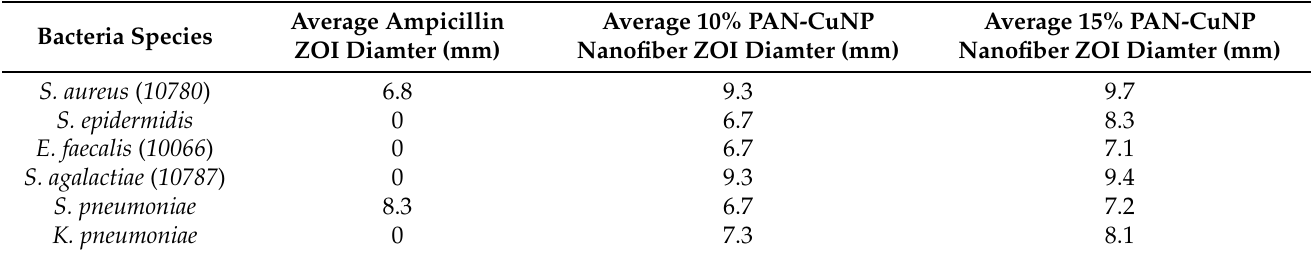
Table 4. Antibacterial Efficiency of PAN-CuNP nanofibers Synthesized from Different wt.% of CuSO 4 on Various Bacteria